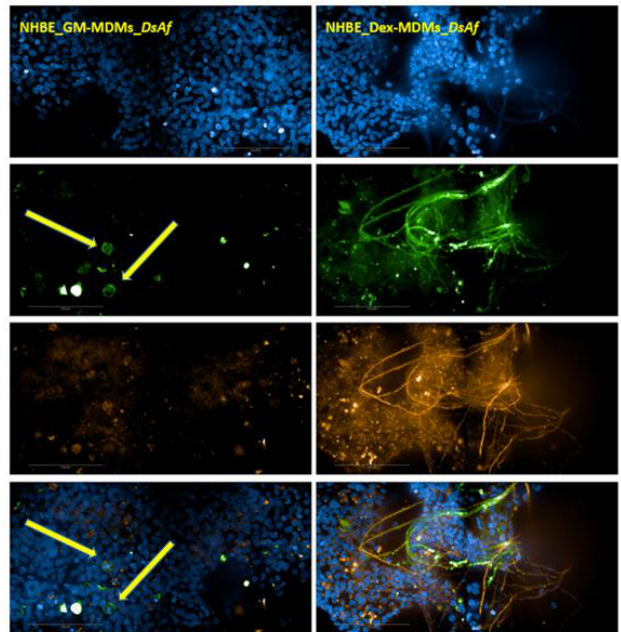
Figure 5. Growth and germination of DsRed-expressing A. fumigatus were enhanced within the dexamethasone-treated 3D lung model cocultured with macrophages. Pseudostratified primary epithelia, 40 days in ALI, are depicted. Arrows show intact GM–MDMs, which prevented growth 24 h post-infection. 20XW Objective, N.A.